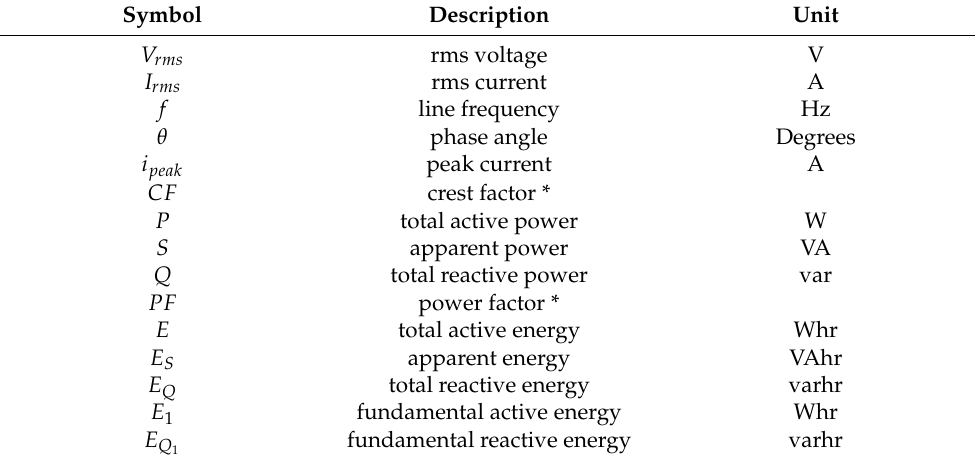
Table 4. ADE7878A